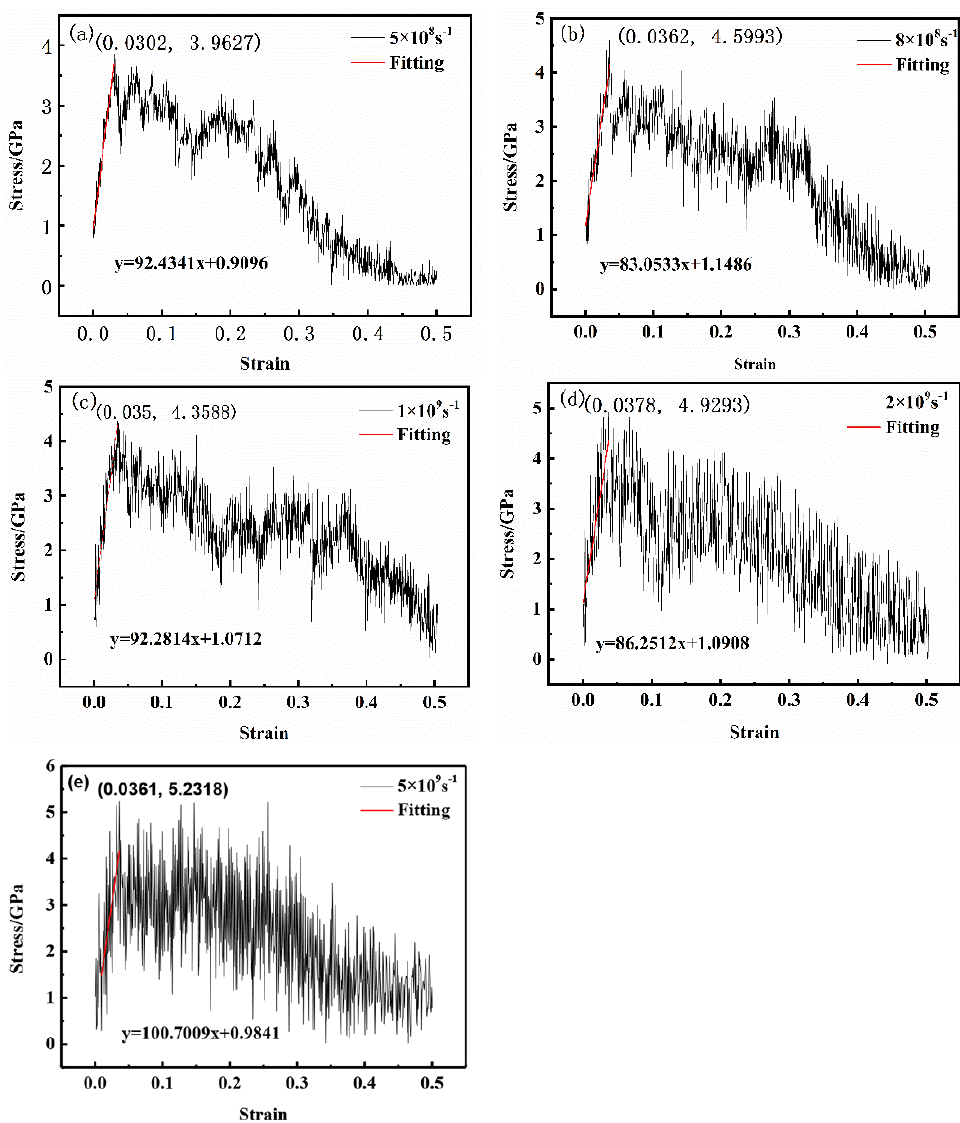
Figure 5. Stress–strain curves of GB-HEA at different loading rates at 300 K: ( a ) 5 × 10 8 s − Figure 5. Stress – strain curves of GB-HEA at different loading rates at 300 K: ( a ) 5 × 10 8 s −1 ( b ) 8 × 10 8